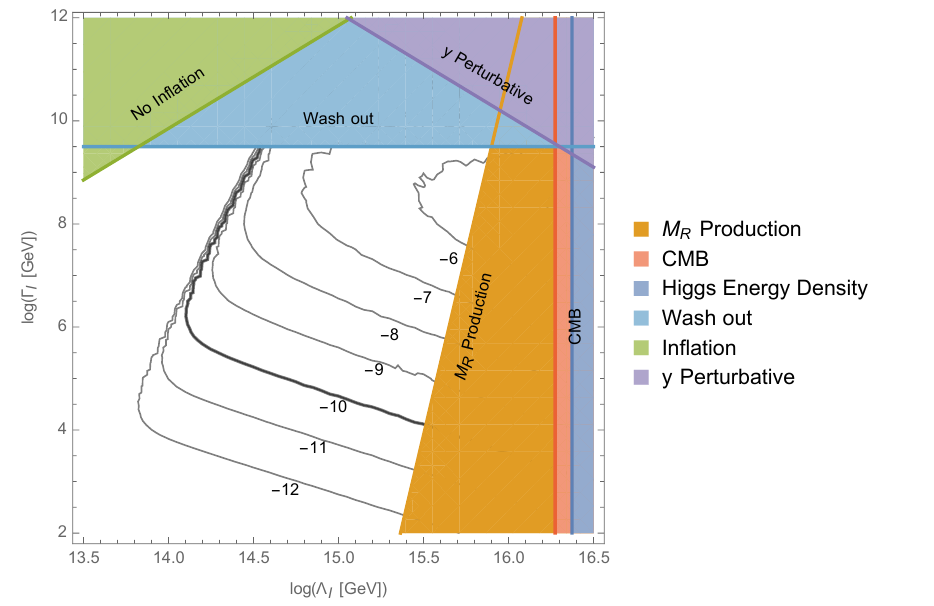
Figure 9 . The parameter space for forced relaxation with respect to in(cid:13)aton decay width, (cid:0) I , and the scale of in(cid:13)ation, (cid:3) I . The contours denote the logarithmic power of the (cid:12)nal lepton asymmetry ( n = log Y L ). The shaded region is the parameter space excluded by various kinds of constraints. 10